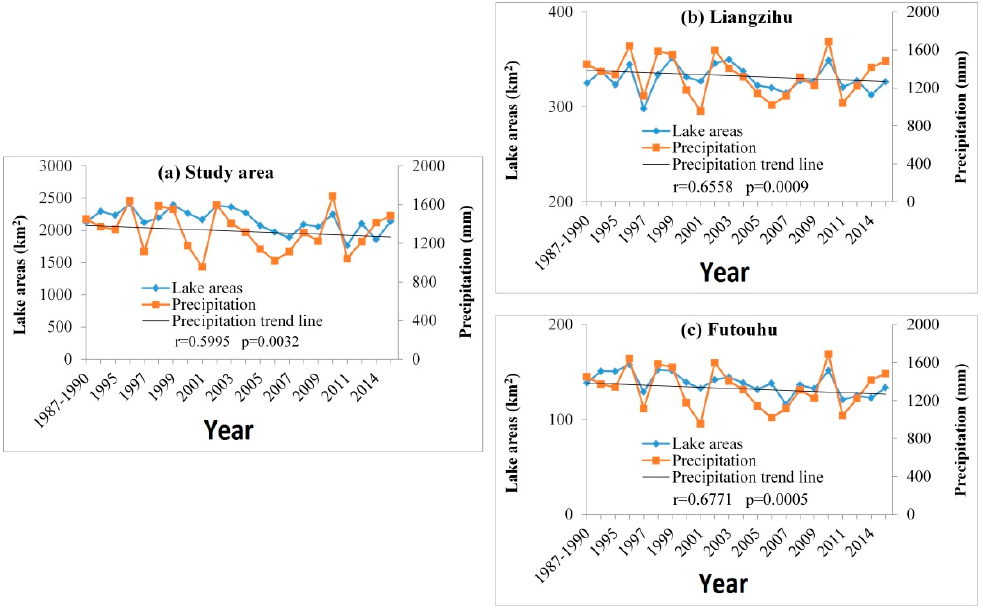
Figure 9. Correlation between annual maximum lake areas and annual precipitation from 1987 to 2015.